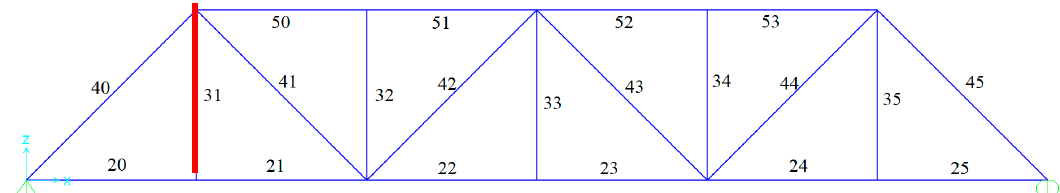
Figure 6. DFN v obtained from the baseline bridge considering measurement noise and operational variation.